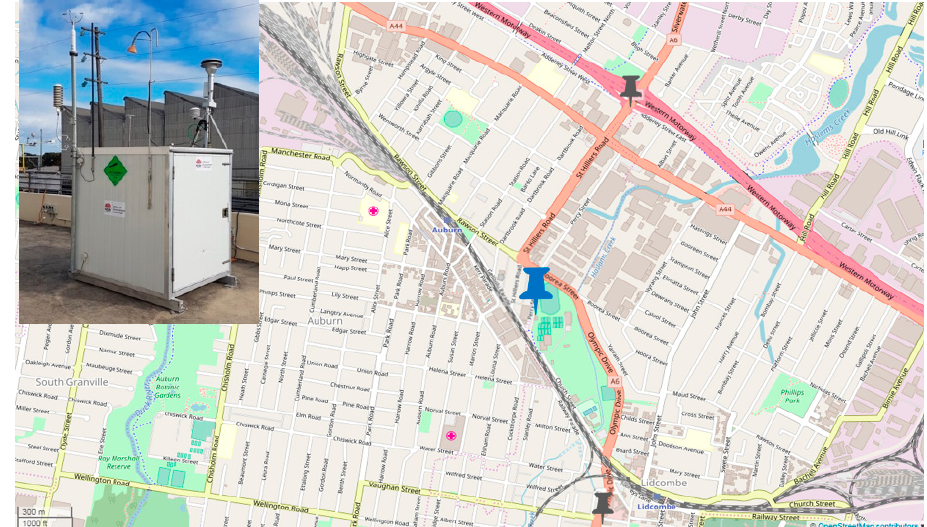
Figure 1. Inset-The mobile air quality station (MAQ) in position at the Auburn balcony site. Main image map indicating the position of the MAQ (blue pin) and the surrounding roads. Location of Silverwater Road (north) and Olympic Drive (south) traffic counters are indicated by grey pins. Note the presence of the major A6 road 330 m east of the site. Generated in OpenStreetMap ®.